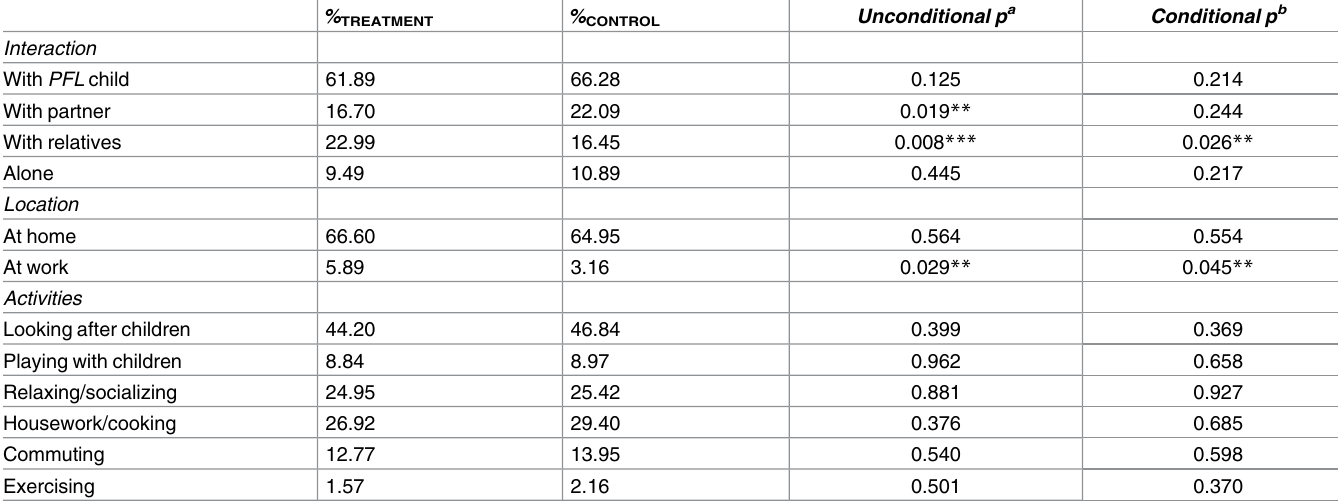
Table 6. Time Use Amongst Treatment and Control